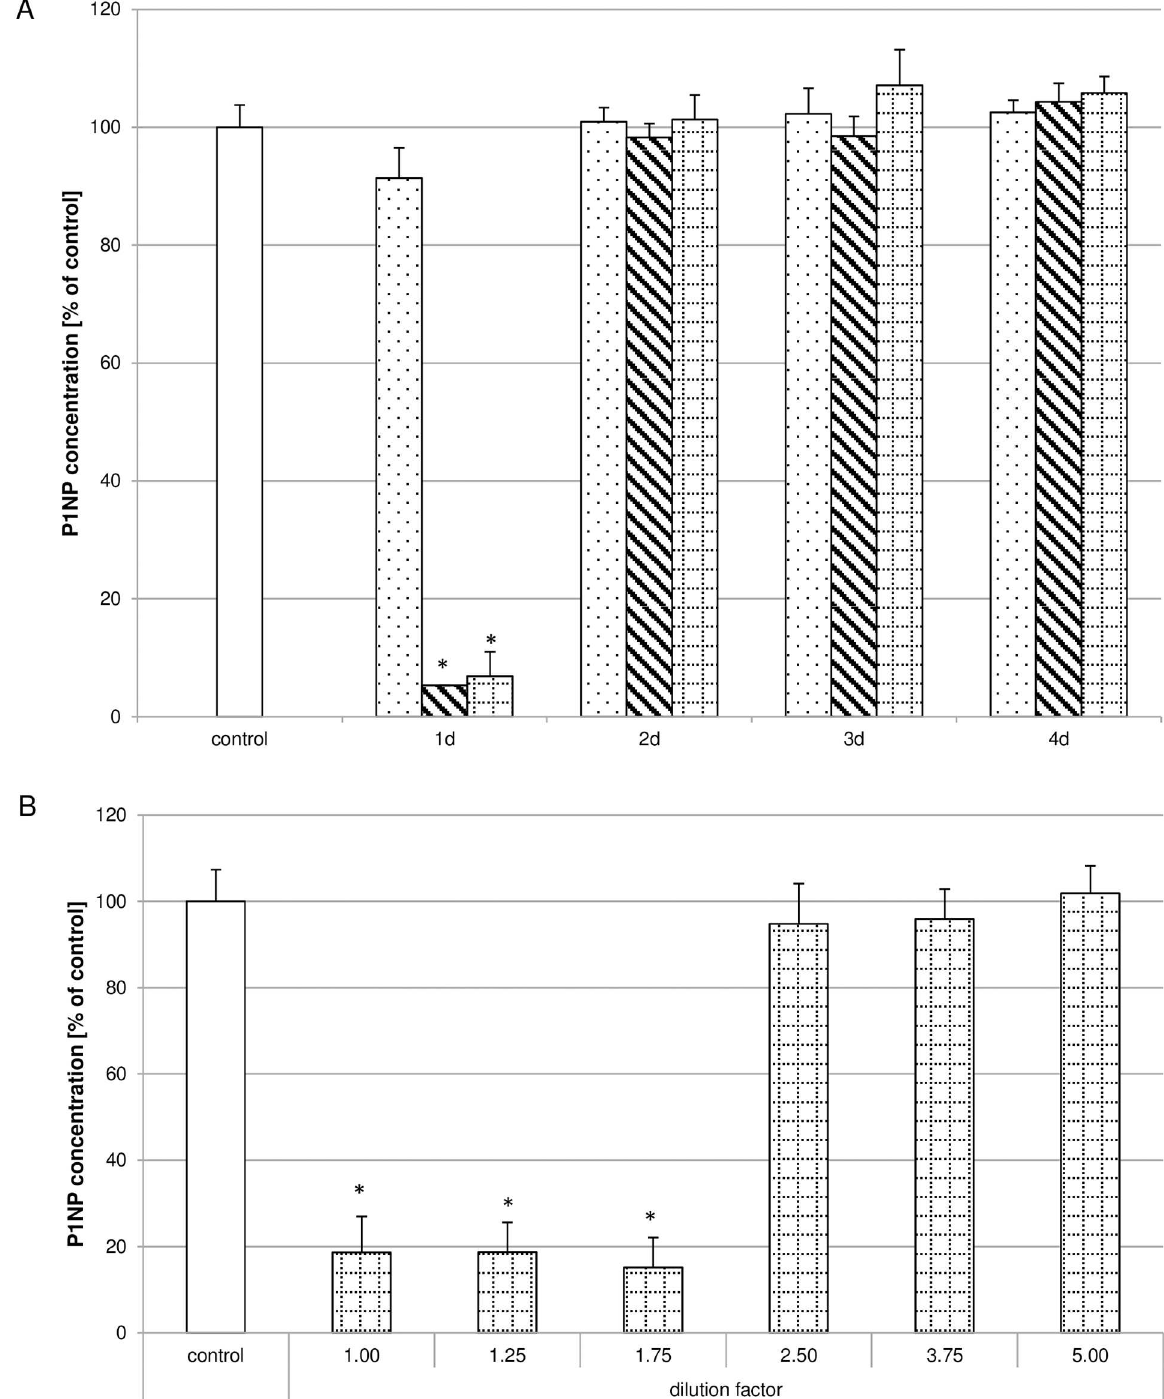
Fig 5. Biodentine ® suspensions decreasedthe concentration of the N-terminal domain of pro-collagen type I (P1NP). Collagentype I synthesis was evaluatedmeasuring P1NP concentrations of cultures left untreated(white bar) or treated with Biodentine ® suspensions of low (dotted bar), moderate (striped bar) or high (bricked bar) Biodentine ® concentrations. P1NP in pulp cells treated with the Biodentine ® suspensionsof day 1 was severely reduced(A; N = 180). Serial dilutionsof the high Biodentine ® concentrations containingsuspensionsof day 1 revealedthat up to a serial dilutionof 1.75, P1NP secretionwas reducedwhereas dilutions from 2.5 did not influenceP1NP secretion(B; N = 84). The data displayedare representative of three